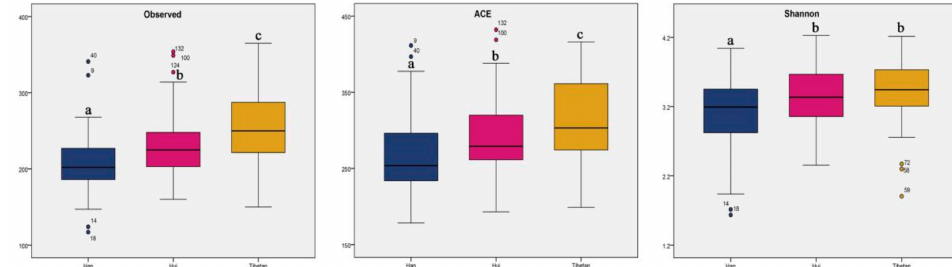
Figure 3. Box plots of alpha diversity in Han (blue), Hui (red), and Tibetan (yellow) ethnic groups on the basis of the number of observed species, ACE, and Shannon index. a,b,c indicate significant di ff erences between groups.